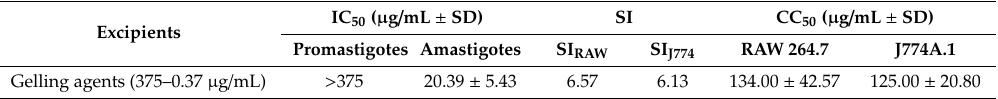
Figure 10. Effect of the MA gel on the infection of J774A.1 macrophages with L. infantum . ( A ) Infected and untreated control cultures. ( B ) Cultures treated with 15.63 µg/mL of Sb V of the MA gel. Amastigotes are indicated by arrows.